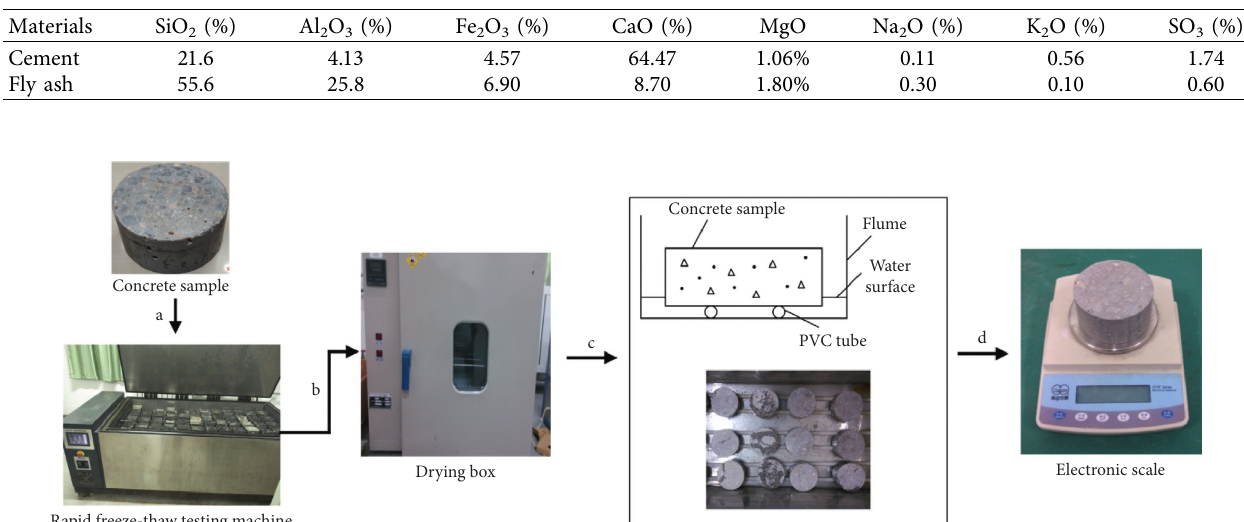
Figure 1: Schematic diagram of test procedure to determine water absorption performance.